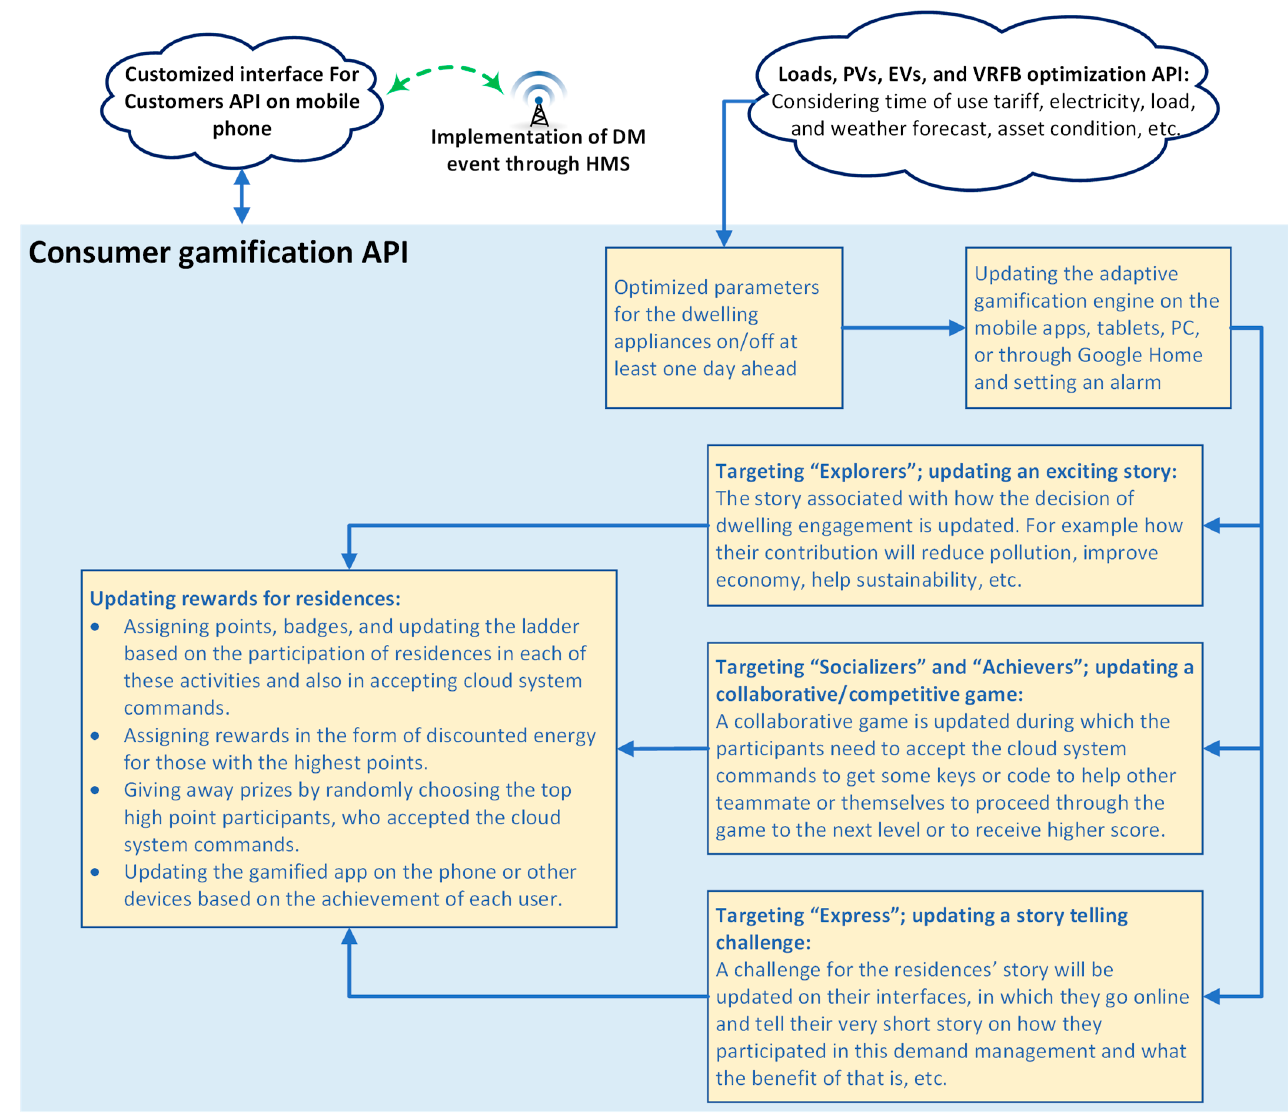
Figure 5. The proposed framework for gamification system for customer engagement. DM: demand management. Table 1. Manageable/shiftable